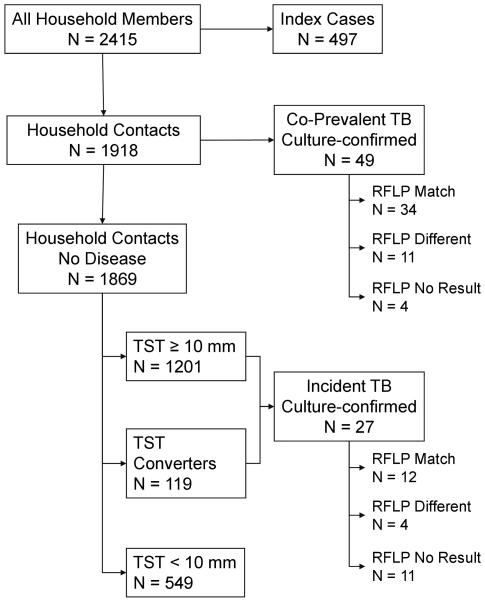
Distribution of tuberculosis and latent tuberculosis infection among 2415 households in Kampala Uganda, 1995–2004.